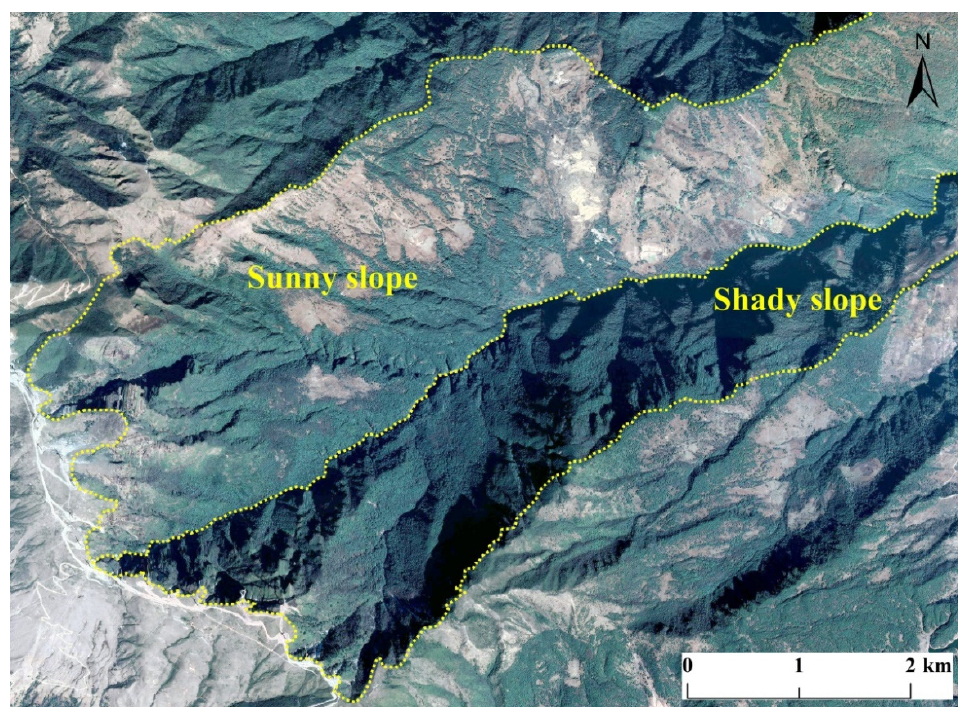
Figure 10. Topographic and vegetation characteristics of typical shady and sunny slopes in the study area, there is a gully between the sunny slope and the shady